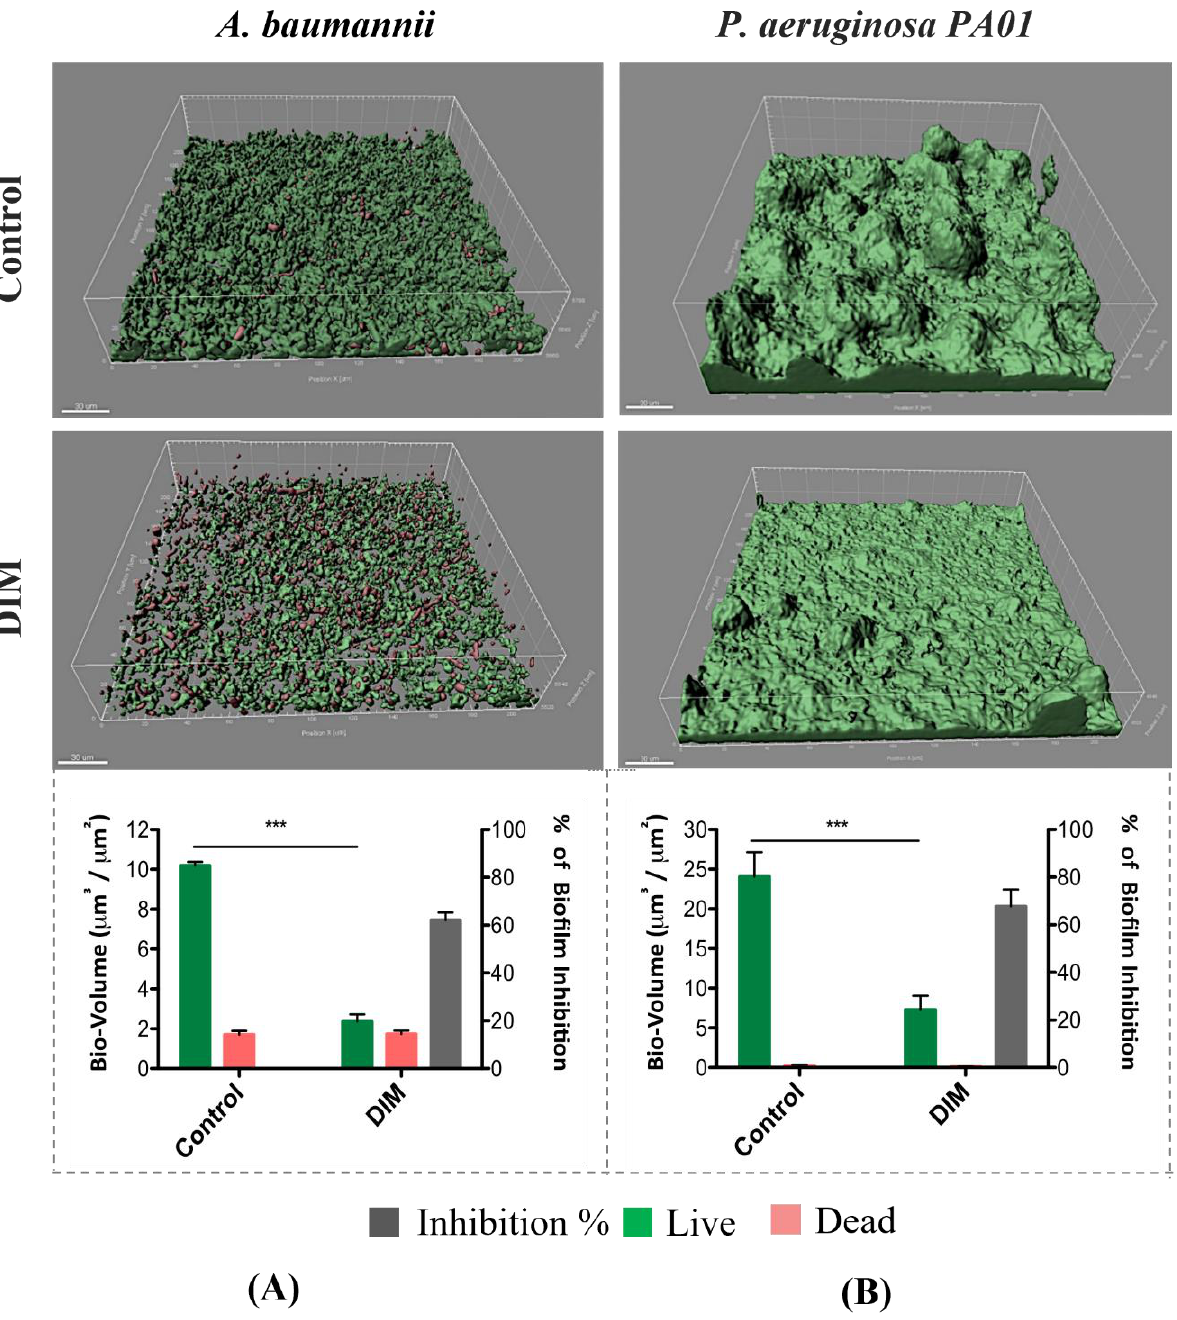
Figure 1. Prevention of the formation of biofilm by A. baumannii ( A ) and P. aeruginosa PA01 ( B ) in a flow system during 48 h of incubation with continuous supplementation of 50 µ M DIM. Biofilms were stained with the LIVE/DEAD bacterial viability kit. Quantification of live, dead, and total bio-volumes ( µ m 3 / µ m 2 ) based on image analysis and data from the IMARIS software together with % biofilm inhibition. Images were acquired from three different areas in each treatment, three independent repetitions. Asterisks indicate significant differences compared to control (independent samples t -test; *** p <